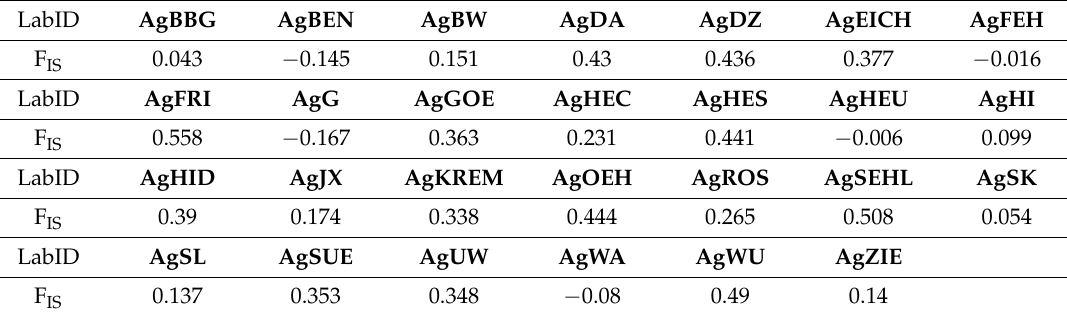
Table 3. F IS -values calculated over 16 markers for each of the 27 occurrences. The LabID is presented in bold letter